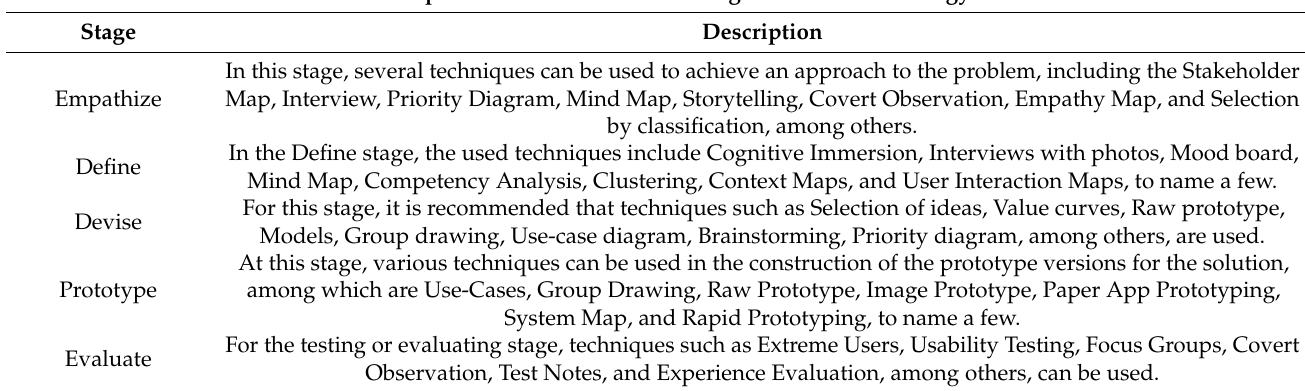
Table 2. Some techniques used in the design thinking stages